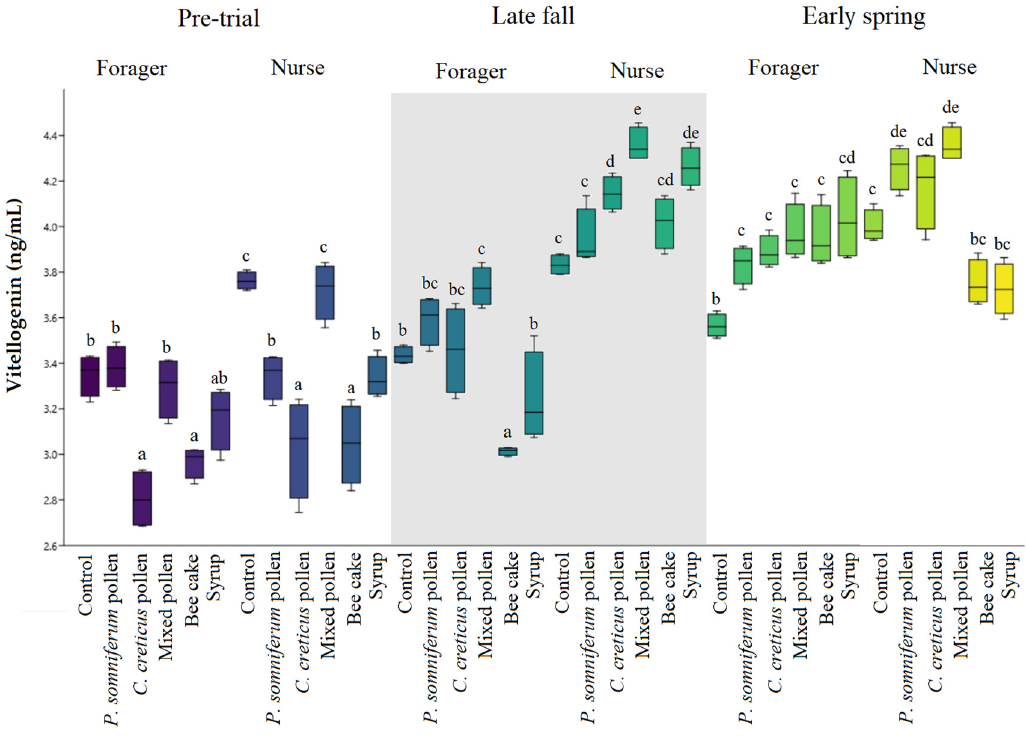
Figure 1. Vg content/values of groups in late fall (Period 1) and early spring (Period 2). Different letters denote significant differences ( p < 0.05).